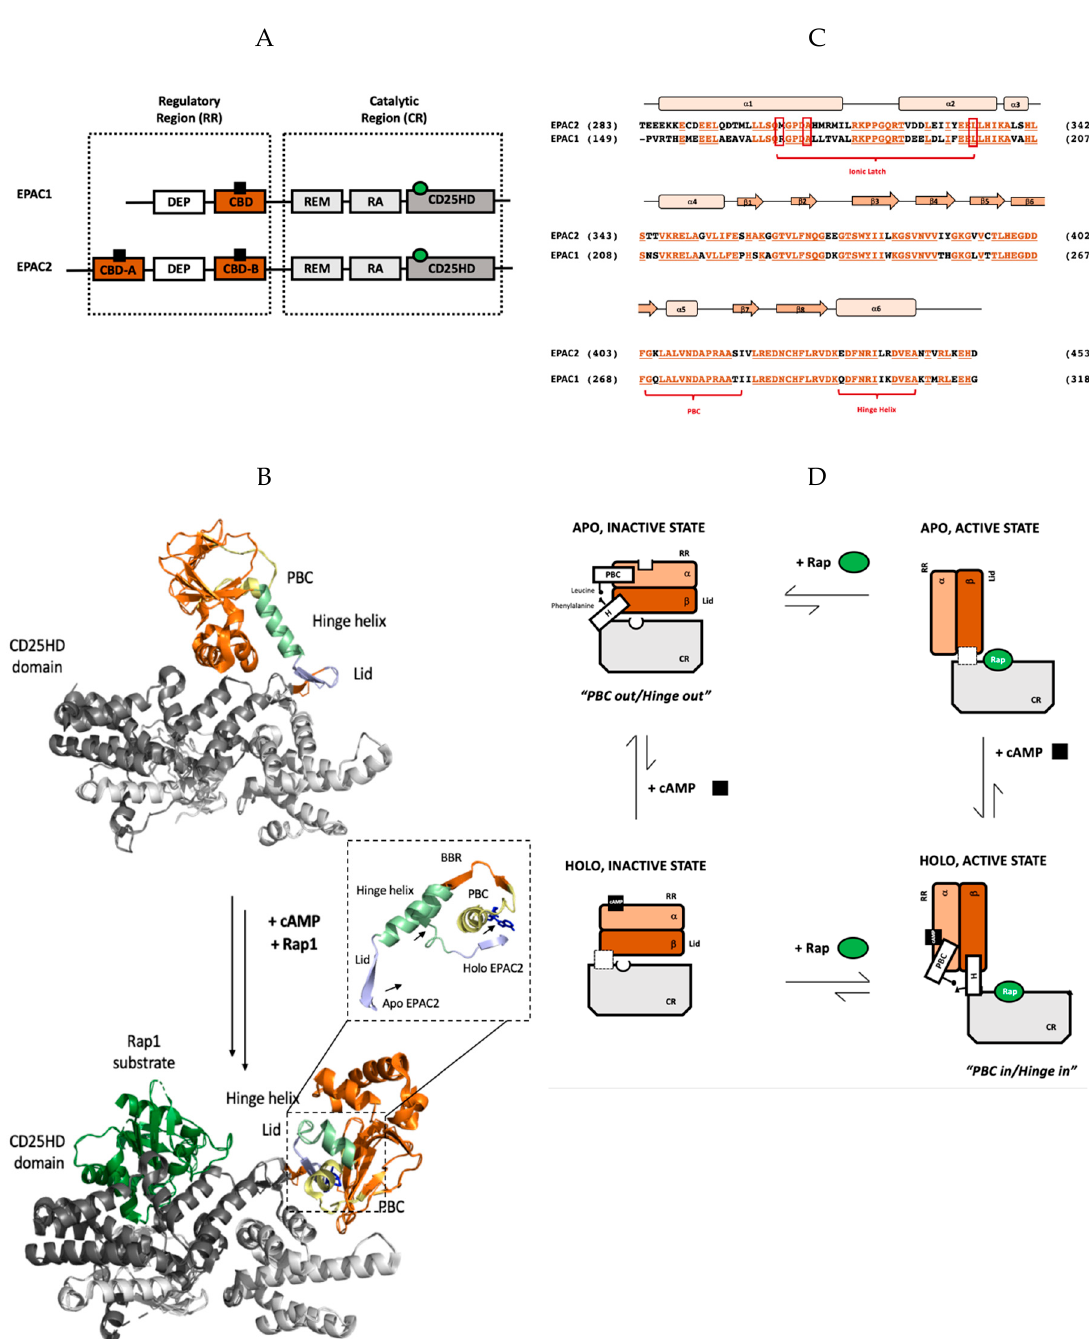
Figure 1. Structure and thermodynamics of the cAMP binding domain (CBD)-binding domain of EPAC. ( A ) Domain organization of Exchange Protein directly Activated by cAMP (EPAC) isoforms 1 and 2 with catalytic and regulatory regions indicated. cAMP is shown as a black square bound to the CBDs (highlighted in orange) in the regulatory region and the Rap protein substrate is represented by a green circle bound to the CD25 homology domain (colored dark grey), which is responsible for EPAC’s GEF activity. EPAC2 has an additional N-terminal CBD that is dispensable in the regulation of EPAC’s catalytic activity in response to cellular cAMP levels. ( B ) Global changes in EPAC2 structure upon cAMP binding. In both the apo, inactive state (top) and holo, active state (bottom), unless otherwise specified CBD-B is shown in orange and the catalytic region is shown in grey. Additionally, the PBC, hinge helix, lid region, and CD25HD domain are indicated in yellow, pale green, light blue, and steel grey, respectively; the Rap1 substrate protein is shown in dark green bound to the holo active state and the ligand Sp-cAMPS is indicated in dark blue. Only residues common to